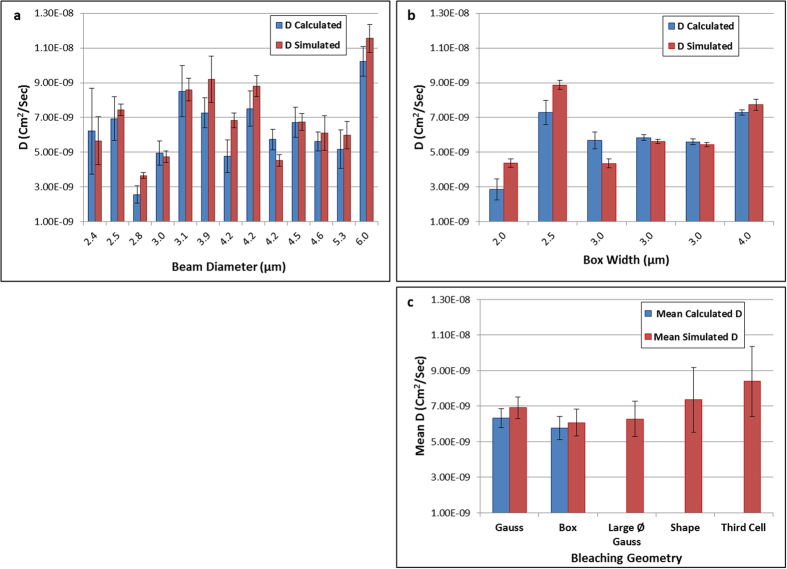
Comparison of Calculated and Simulation Extracted Diffusion Coefficient (a) Results of 13 single experiments using circular bleaching; the beam diameter is the value extracted from the post-bleach frame, using angular averaging. The resulting diffusion coefficient is clearly not correlated with the diameter of the bleached region. (b) Results of rectangular bleaching pattern. Box width (w) was left as a free fitting parameter in fitting Eq. (3) to the data. Error bars account for uncertainty in the determination of beam diameter (Gauss) or width (Box) (for analytical calculation) and iteration time (for simulation). (c, two leftmost columns) Comparison of mean (over all experiments: 13 for circular and 6 for rectangular) diffusion coefficient extracted with the analytical models, with the simulation approach. The mean differences between calculated (blue) and simulated (red) diffusion coefficients are statistically insignificant. (c, three rightmost columns) the mean diffusion coefficient of a large diameter Gaussian bleached spot, arbitrary shape and a third of a cell calculated using the simulation approach. Error bars represent SEM.